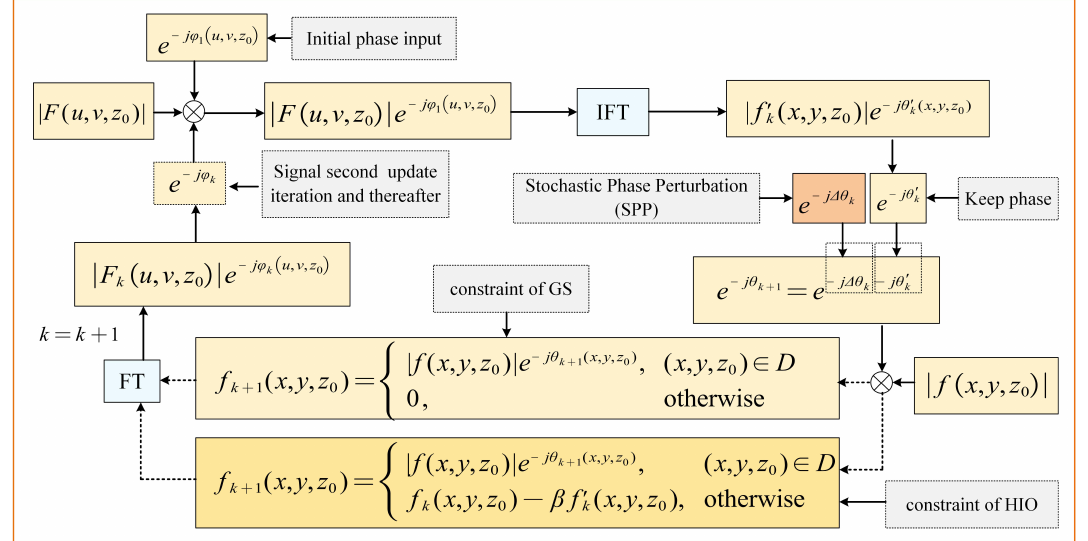
Figure 4. Flow chart of SPP GS / SPP HIO algorithms for signal